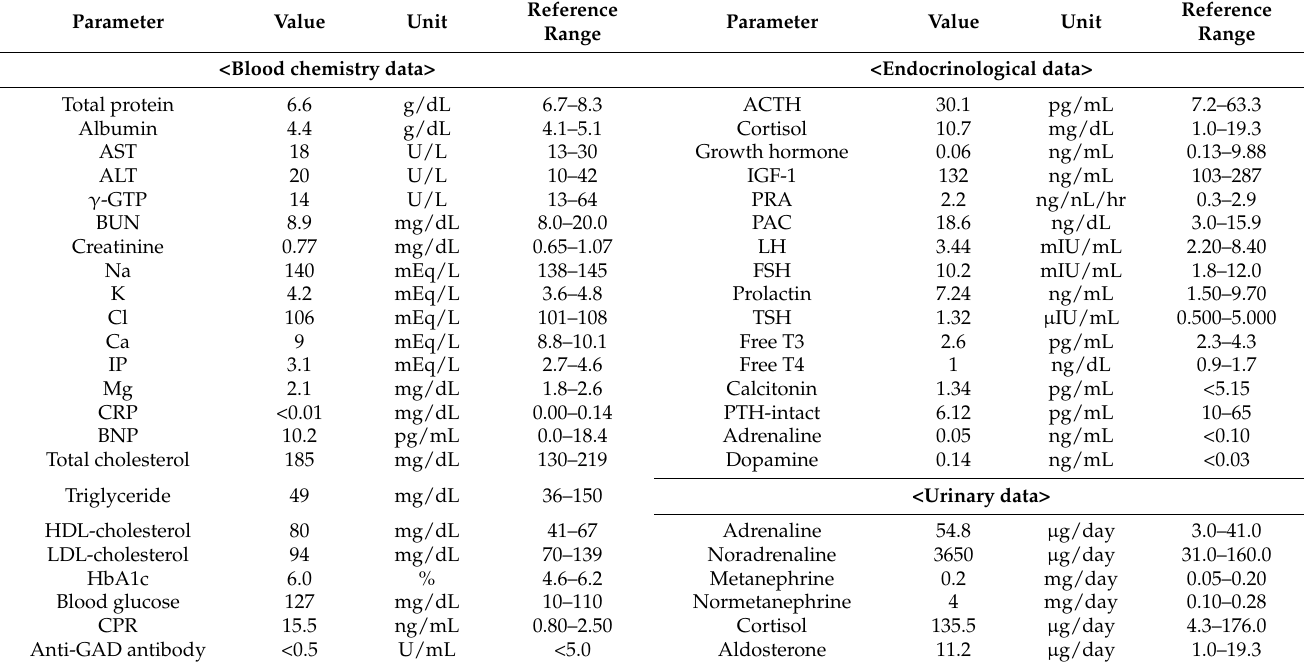
Table 1. Laboratory data on admission.